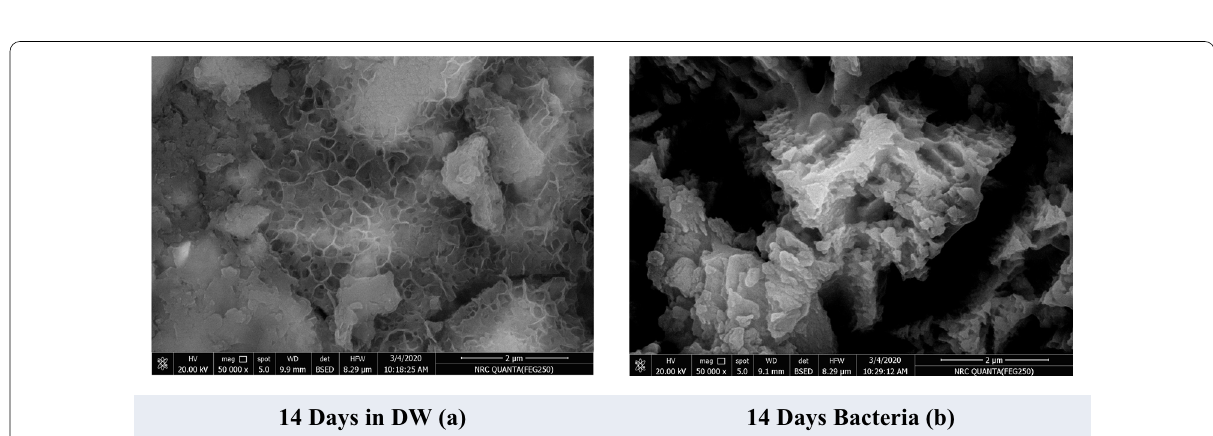
Fig. 10 SEM micrographs of 14-day sample cured in distilled water (DW-plate a ) and Streptococcus thermophilus bacteria in nutrient broth NB media (plate b